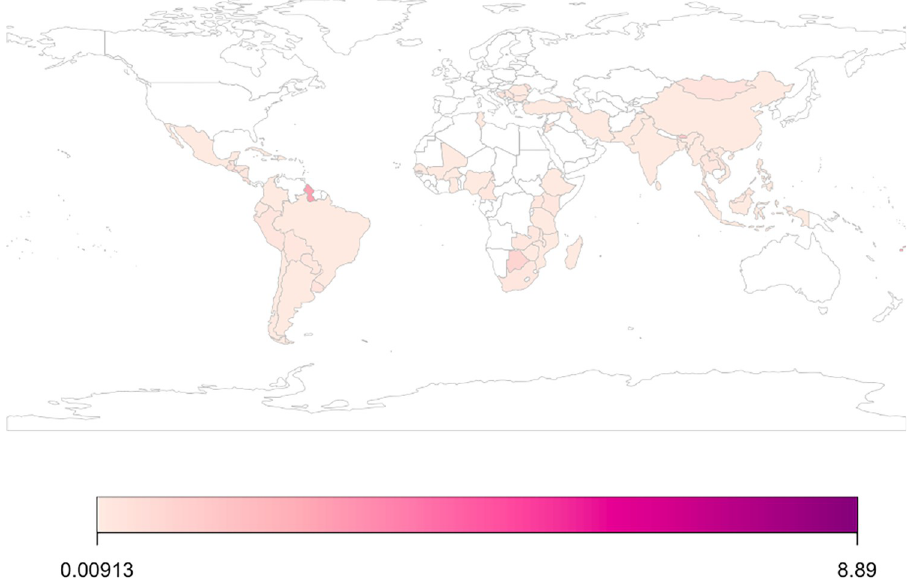
Fig 3. Distribution of studies per 1 million population by country of implementation. We used country population size in 2020 (https://data.worldbank.org/indicator/SP.POP.TOTL) to standardized estimates expressed as number of studies per 1 million population. We used “rworldmap” package (https://cran.r-project.org/web/packages/rworldmap/ rworldmap.pdf) available in R software to present these standardized estimates across countries where interventions were implemented. Country borders in this package are derived from Natural Earth data. Table E in S1 Appendix shows number of included studies per country.